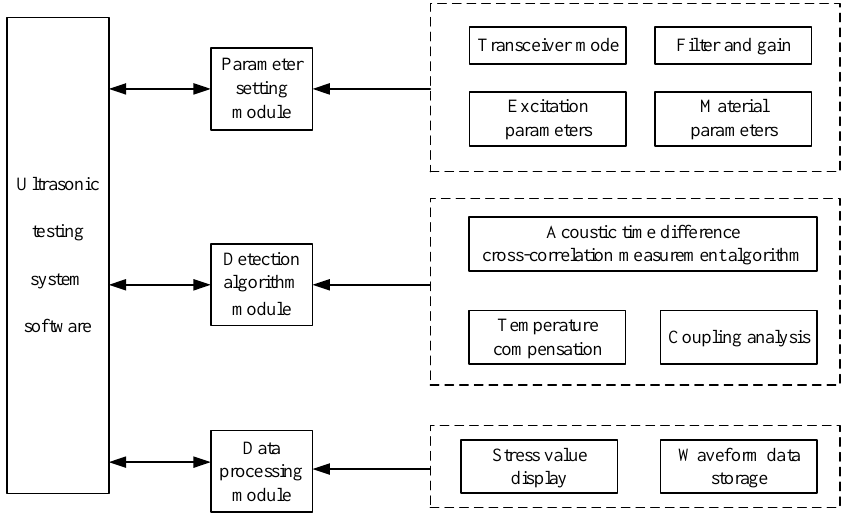
Figure 15. Ultrasonic testing system software structure diagram.